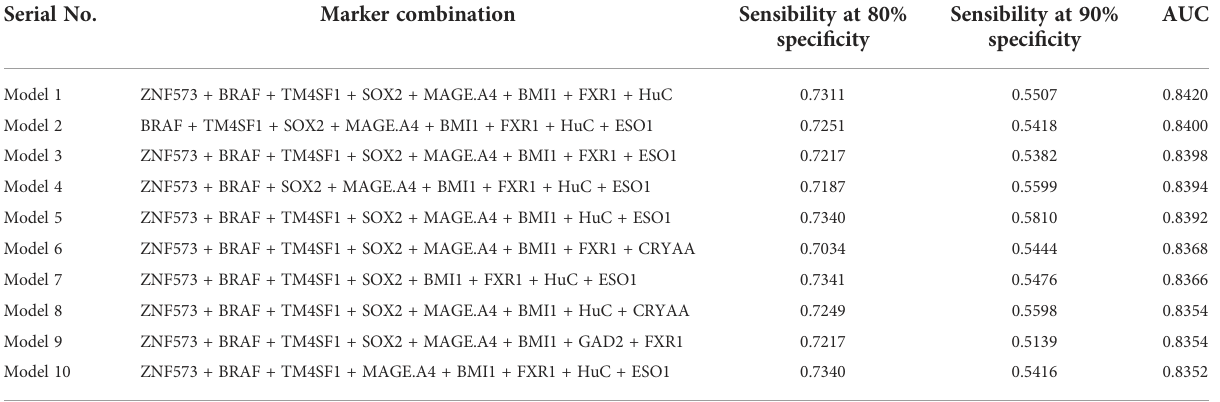
TABLE 6 Top 10 logistic models consisting of 8 lung cancer antigen markers in terms of AUC and their sensitivity at 80/90% speci fi city and AUC under 5-fold cross-validation. Serial